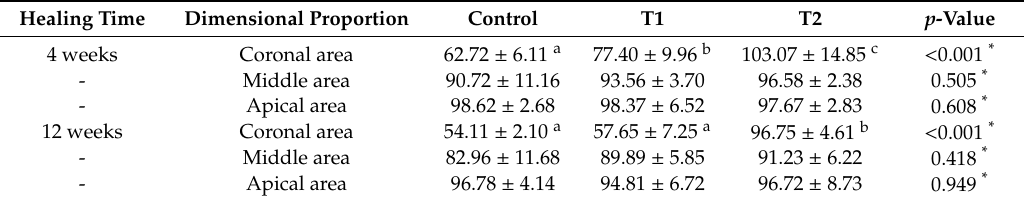
Table 2. Results of the quantitative micro-CT analyses of coronal, middle and apical area at 4 and 12 weeks of healing.